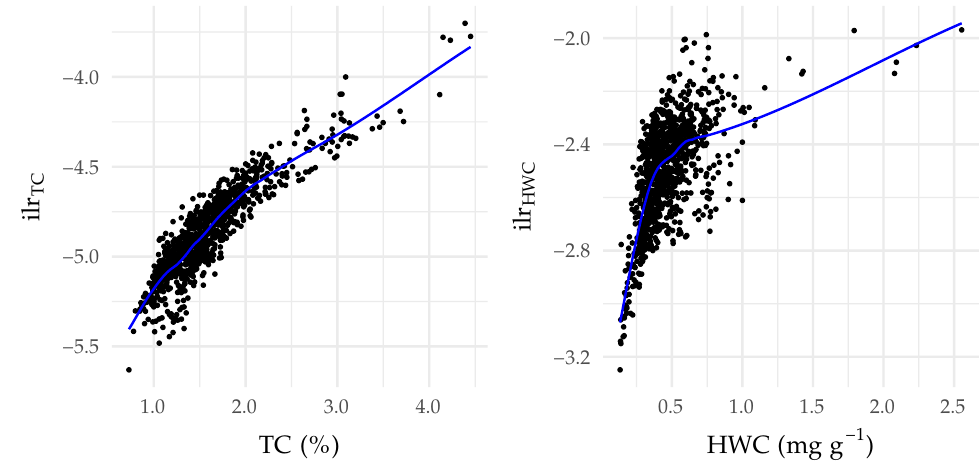
Figure 7. The relationships between raw SC reference measurements and ilr-transformed values, with overlaid loess smoothers.